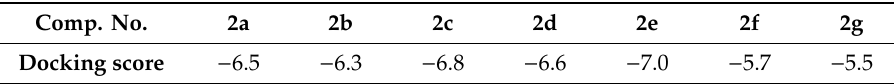
Table 9. Docking scores of compounds 2a – 2g